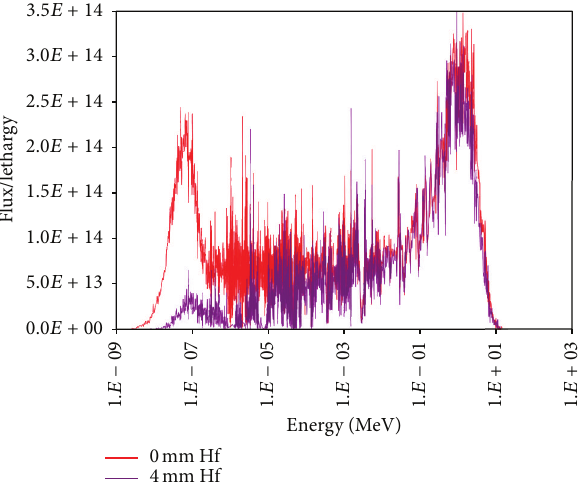
Figure 11: The spectrum in the molybdenum shroud surrounding the fuel [3].